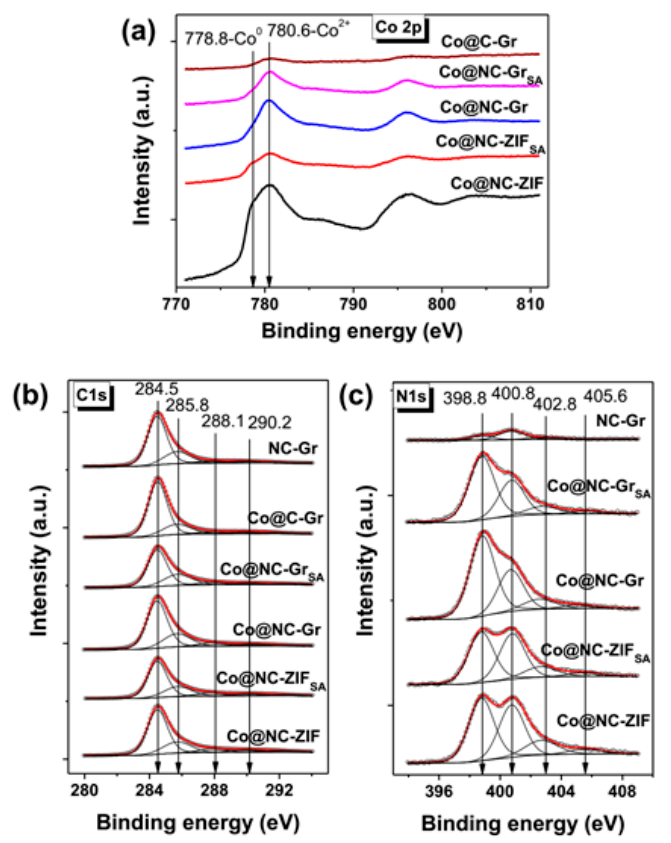
Figure 4. High resolution XPS spectra of ( a ) Co 2p, ( b ) C 1s and ( c ) N 1s of the samples.